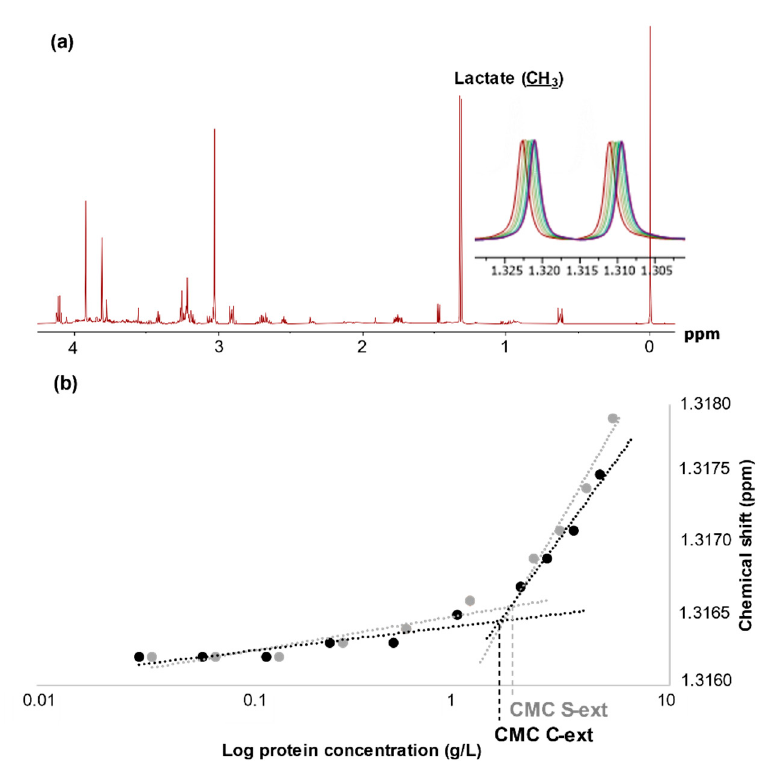
Figure 3. ( a ) 1 H NMR spectra showing the methyl resonance of lactate around 1.3 ppm, with an insert illustrating the change in chemical shift of lactate with decreasing protein concentration of the salmon protein extract dilution series. ( b ) Determination of the critical micelle concentration (CMC) of the direct protein extracts based on cod (C-ext) and salmon (S-ext).